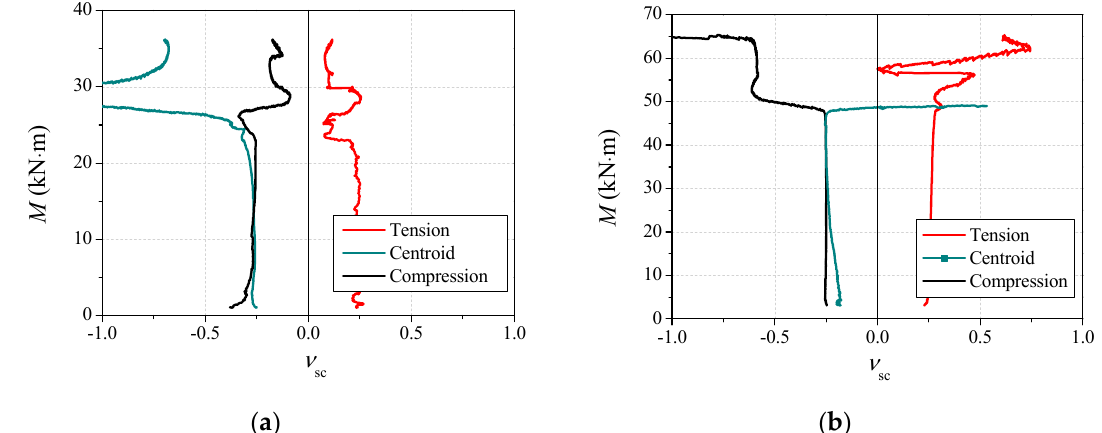
Figure 13. Moment-versus-strain ratio curves. ( a ) t = 4.5 mm; ( b ) t = 10 mm.